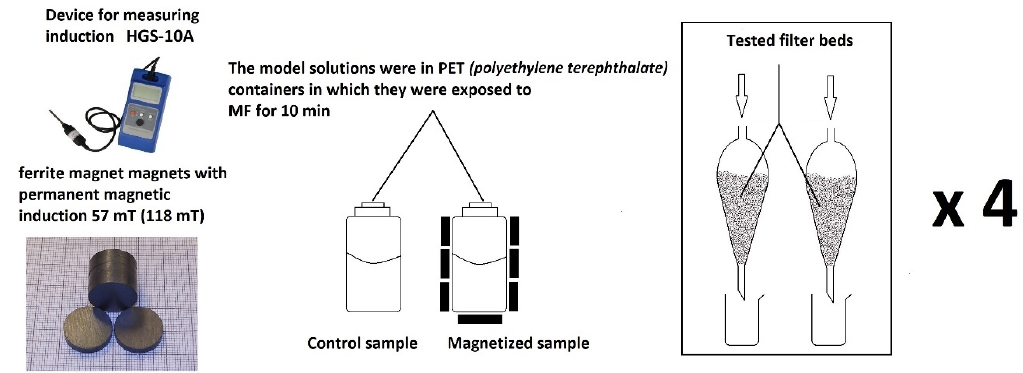
Figure 1. Diagram of the process of control and magnetized samples preparation.